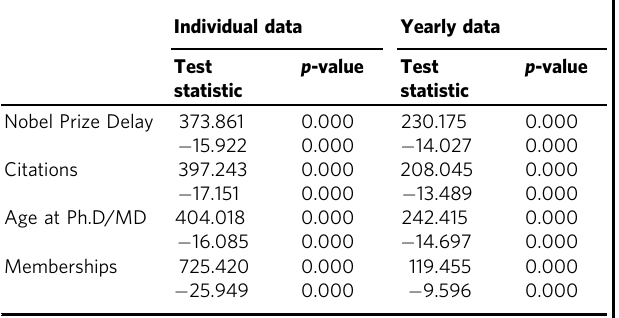
Table 4 Panel data unit root test